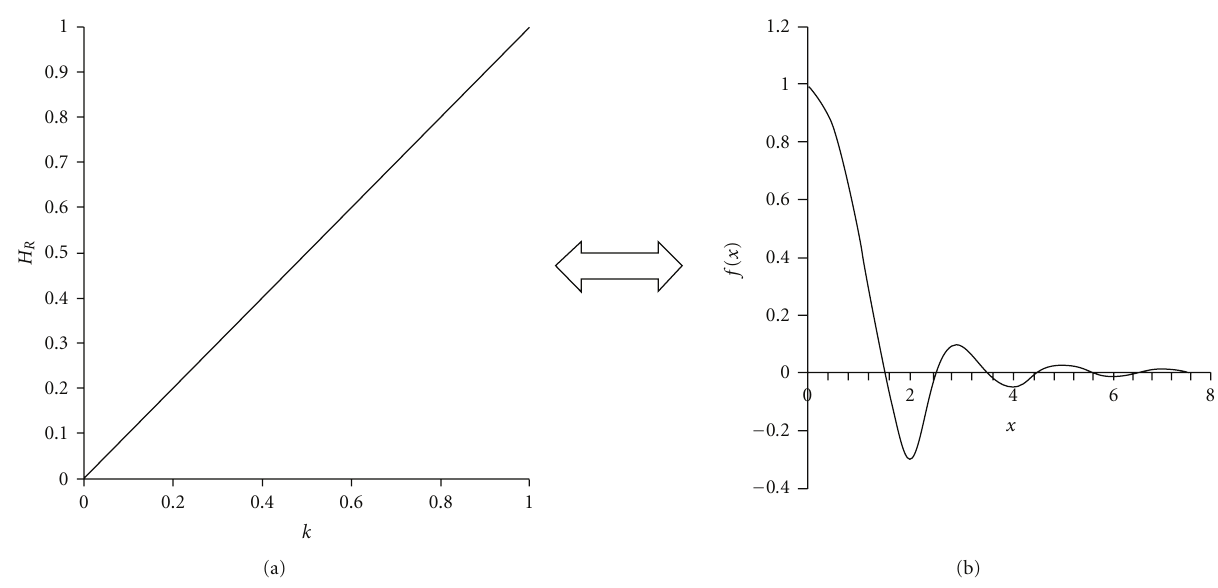
Figure 2: The Ramp filter: (a) Ramp filter in frequency domain. (b) Ramp filter in spatial domain [3].